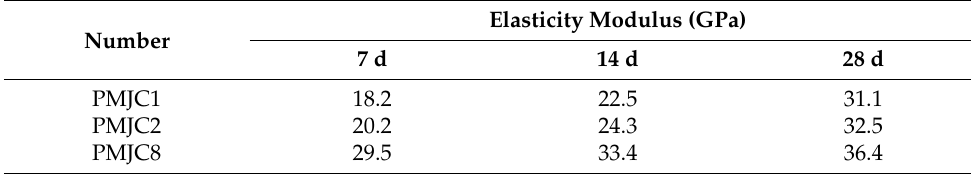
Table 9. Calculated values of the elasticity